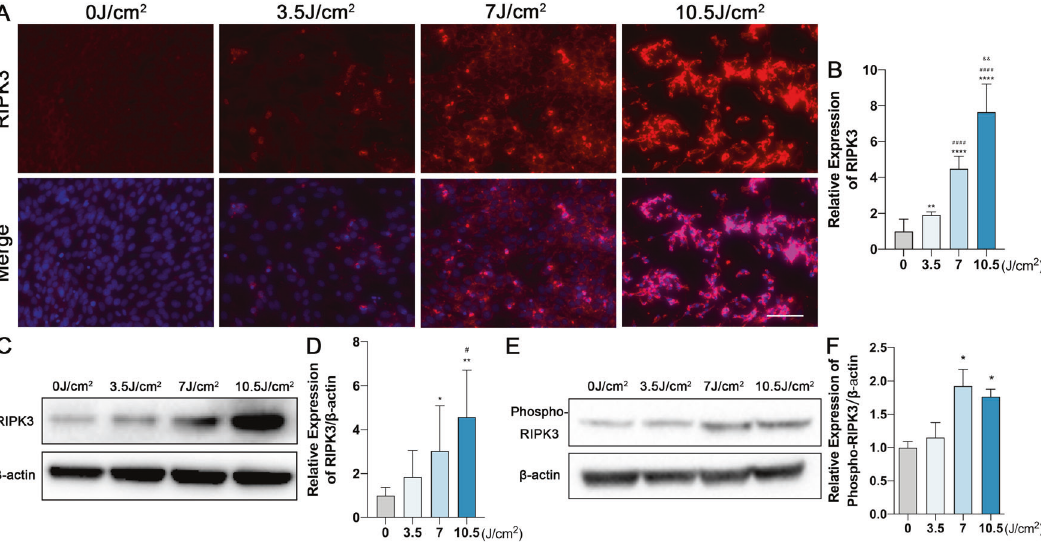
Fig. 2 RIPK3 expression is upregulated by UVA in 661w cells. A , B Representative images and analysis of RIPK3 expression by immuno fl uorescence staining (Scale Bar: 20 μ m) ( n = 6 per group). C , D Representative images and analysis of RIPK3 expression by Western Blot ( n = 6 per group). E , F Representative images and analysis of Phospho-RIPK3 expression by Western Blot ( n = 3 per group). Statistical signi fi cance was analyzed with the unpaired Student ’ s t-test. Statistical signi fi cance of compared with 0 J/cm 2 , 3.5 J/cm 2 , 7 J/cm 2 is indicated as * , # and & . * P , # P or & P < 0.05, ** P , ## P or && P < 0.01, *** P , ### P or &&& P < 0.001, **** P , #### P or &&&& P < 0.0001. All values are expressed as mean ±